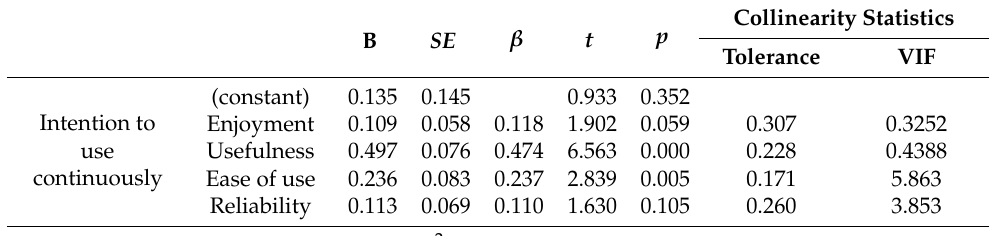
Table 6. Effect of TBSS characteristics on the intention to use continuously.